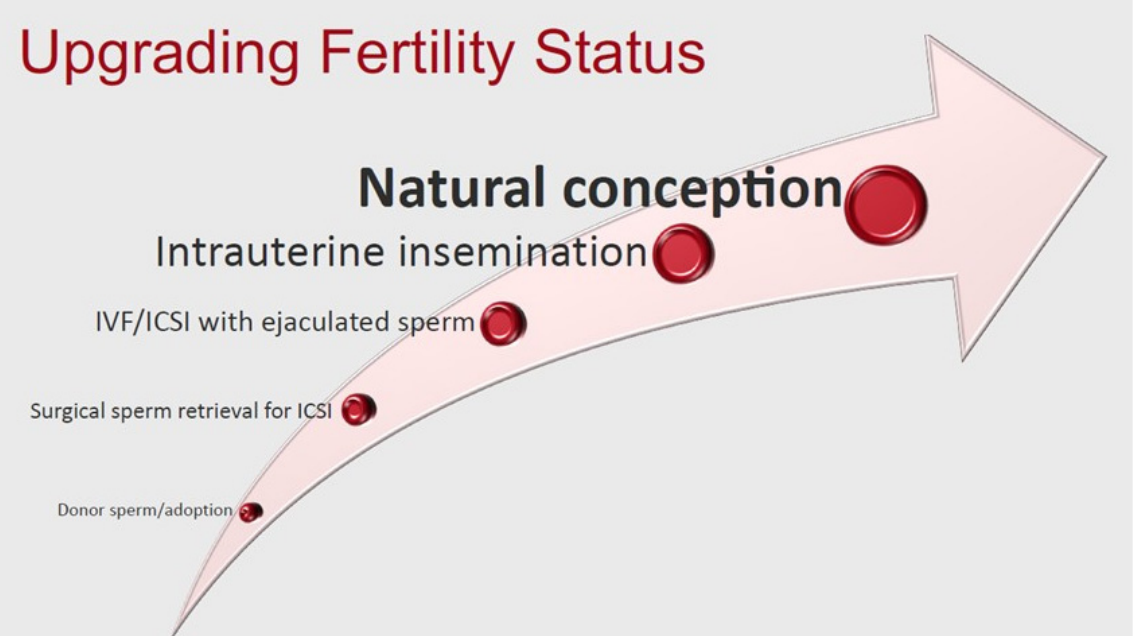
Figure 1. Most couples prefer to conceive naturally. Any treatments that can “upgrade” the fertil- ity status of the couple are